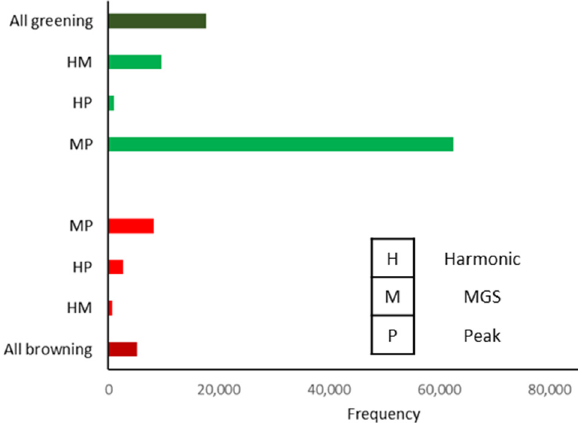
Figure 4. Distribution of trend parameters in relation to each other.